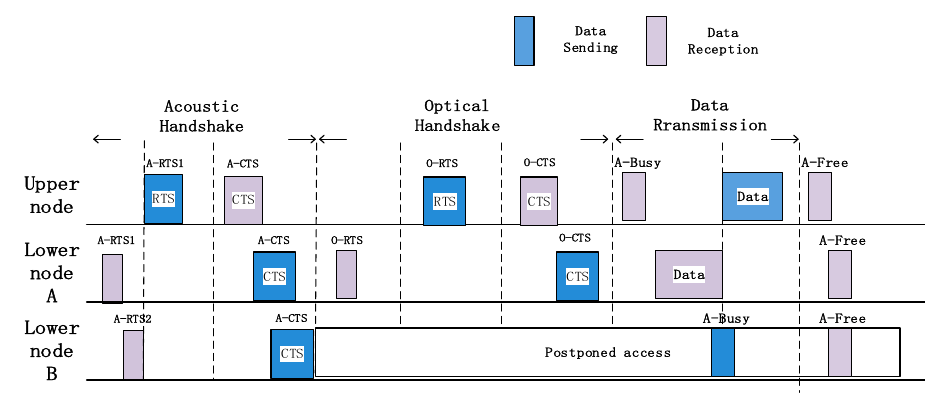
Figure 3. Data transmission between nodes.